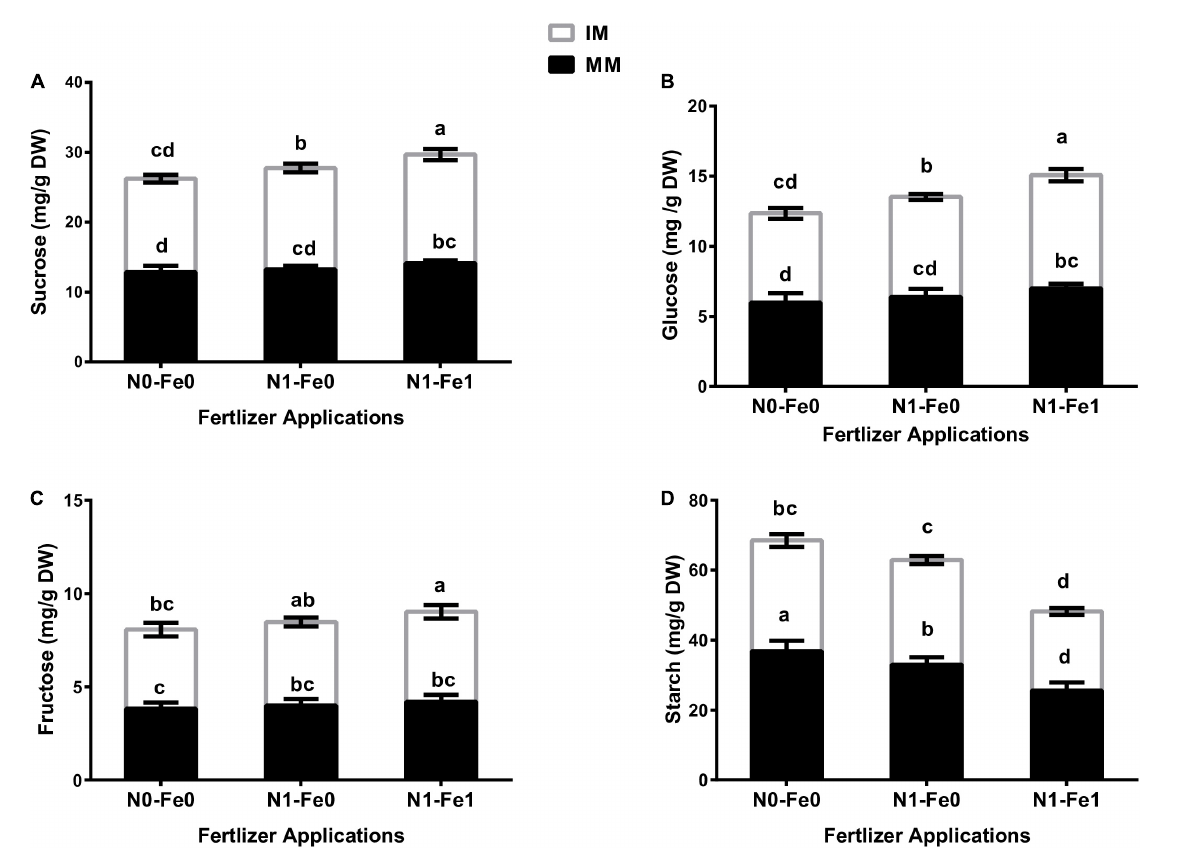
FIGURE5 Soluble sugars such as sucrose (A) , glucose (B) , fructose (C) , and starch (D) content of the maize crops as influenced by different fertilizer and planting patterns. The column graphs with SD bars having lower case letters are significantly different from each other at the LSD test ( p < 0.05). MM, maize mono-cropping; IM, maize intercropping; N0-Fe0, no nitrogen and iron fertilization; N1-Fe0, nitrogen fertilization without iron foliation; N1-Fe1, nitrogen fertilization with iron